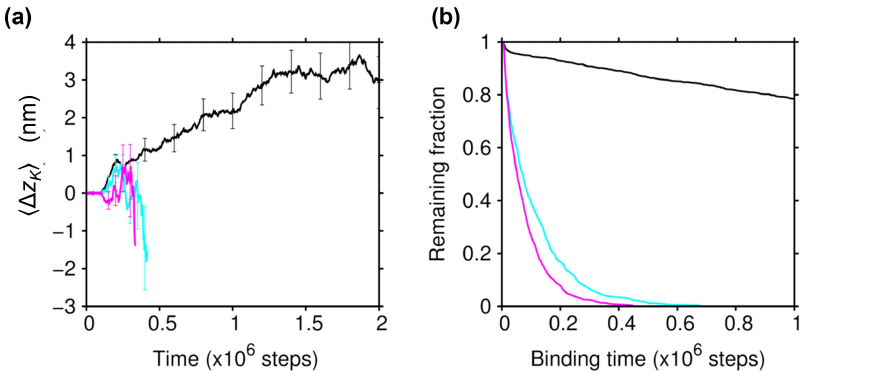
Figure 5. Effect of the CTT modifications on biased Brownian motion. ( a ) The results of (cid:104) ∆ z K ( t ) (cid:105) obtained by binding simulations with modified tubulins where all CTTs (E-hooks) were truncated (cyan) and where all the negatively-charged residues in the CTT were neutralized (magenta). The average time course was terminated at the point where the number of KIF1A bound to the MT became less than 100. Error bars indicate the statistical uncertainty at the 68% confidence interval. For comparison, (cid:104) ∆ z K ( t ) (cid:105) for wild-type tubulin (the same result as in Figure 2b) is displayed (black). ( b ) The fraction of KIF1A that remained bound to the MT is shown as a function of the binding time for the modified tubulins with the CTT truncated (cyan) and with the CTT charge neutralized